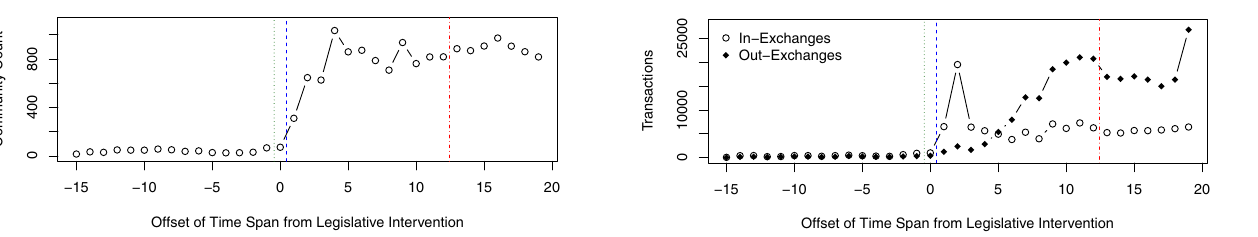
Fig. 10 In- and out-exchanges transaction counts. Temporal representation of the number of transactions cashing in (circles) and cashing out (diamonds) for 30-day spans. The total number of cash-in transactions stabilizes around 5700 transactions. The spike represents the massive reaction that agents have after the announcement of tax-incentives (span 0). The number of cash-out transactions has a positive